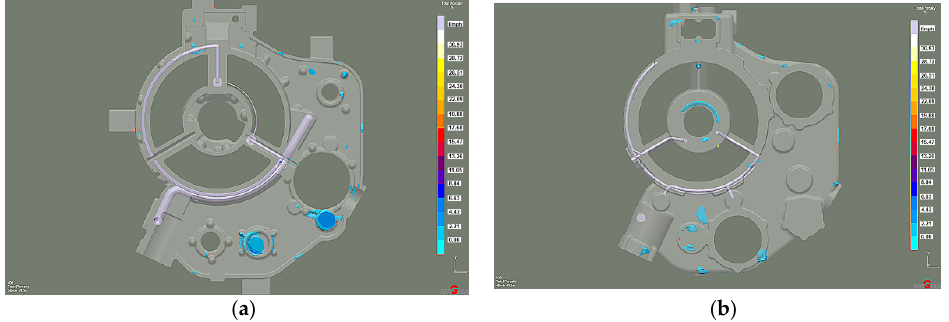
Figure 16. Stage 4 Porosity: ( a ) lower casting part; ( b ) top casting part.